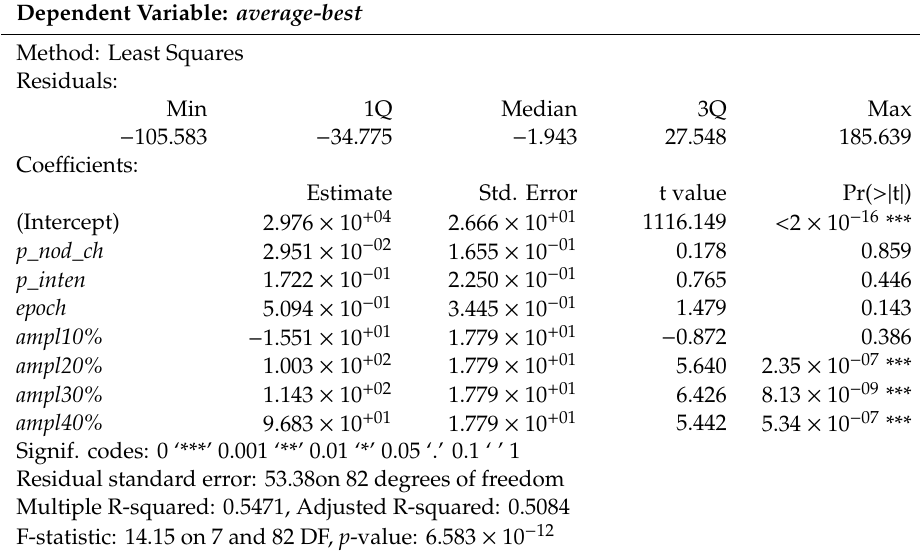
Table 5. Regression model for average-best for fl3795